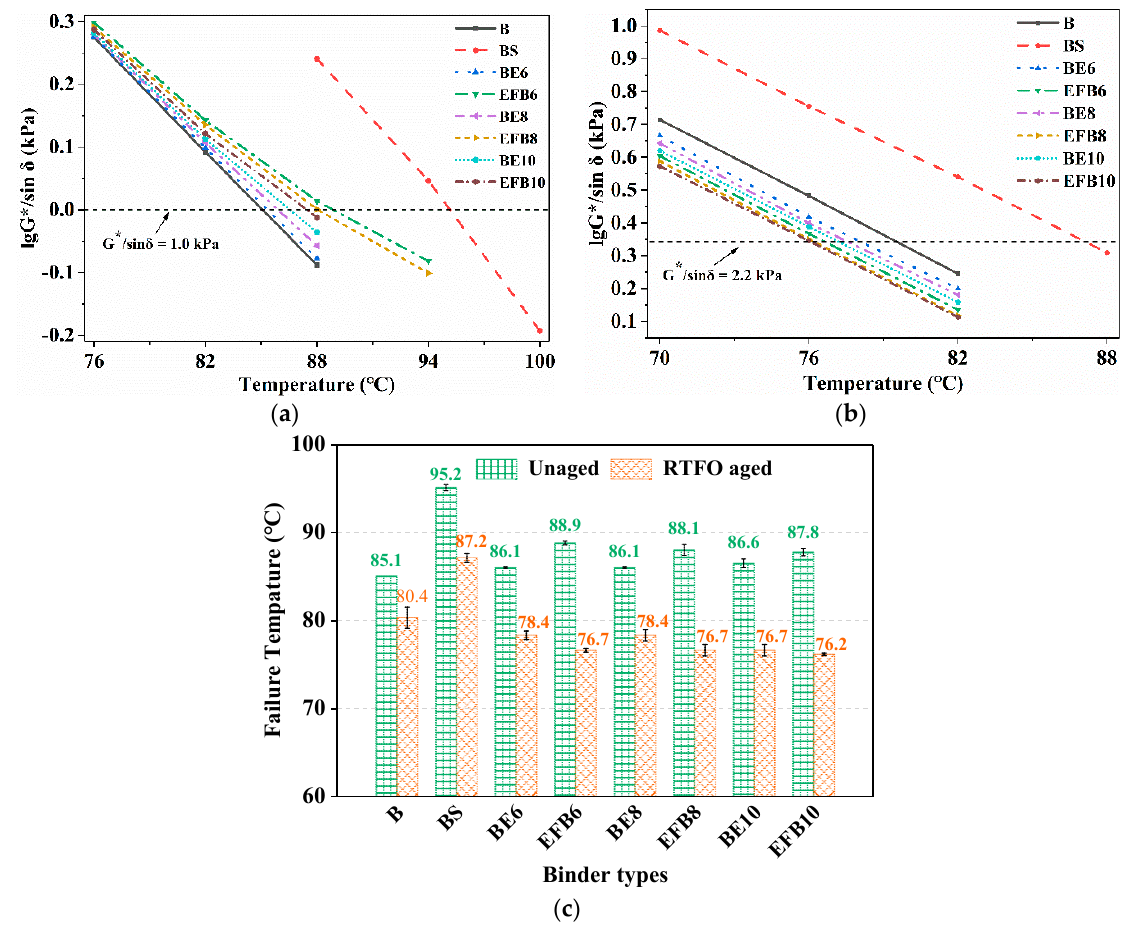
Figure 6. High-temperature performances: ( a ) rutting factors for unaged binders; ( b ) rutting factors for RTFO aged binders; ( c ) failure temperature of unaged binders and RTFO aged binders. Table 4. MSCR test results.